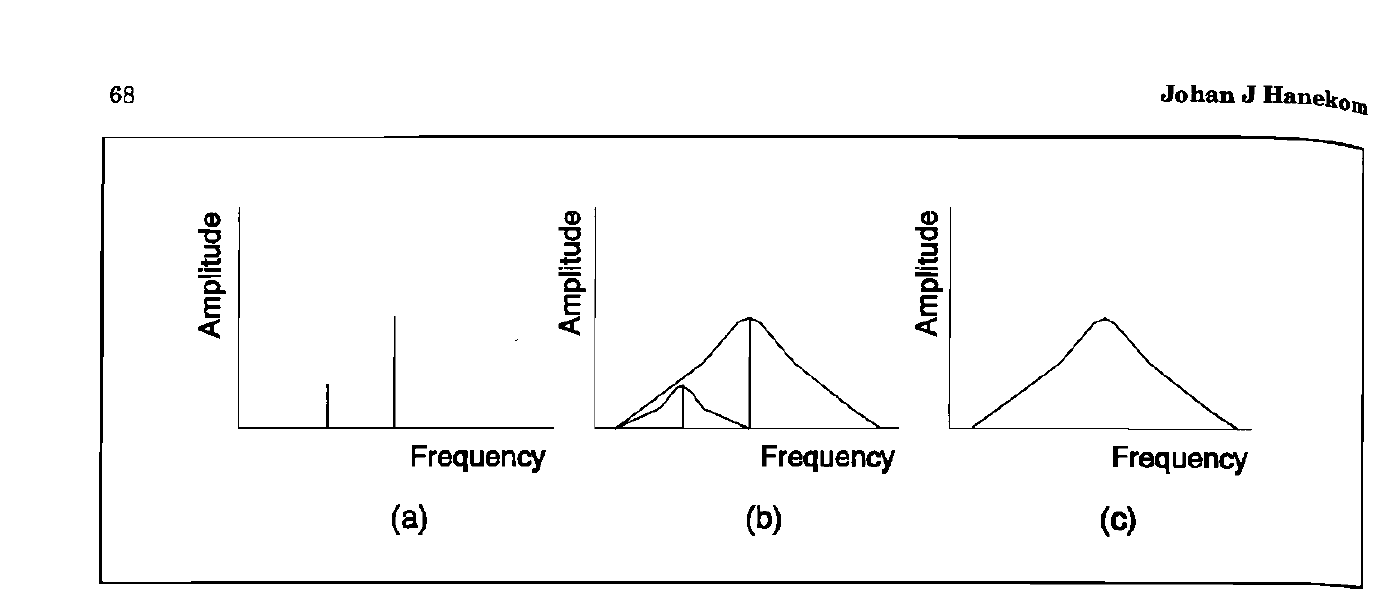
Figure 1. Masking explained conceptually. The frequency spectrum for two pure tones is shown in (a), (b) shows the activation area of each tone, (c) shows the resulting activation area: the activation area of the softer tone is swamped by the louder tone. The louder tone masks the smaller tone, and only the larger frequency component (the louder tone) is audible. The amplitude axis might represent the displacement of the basilar membrane or, alternatively, the neural firing